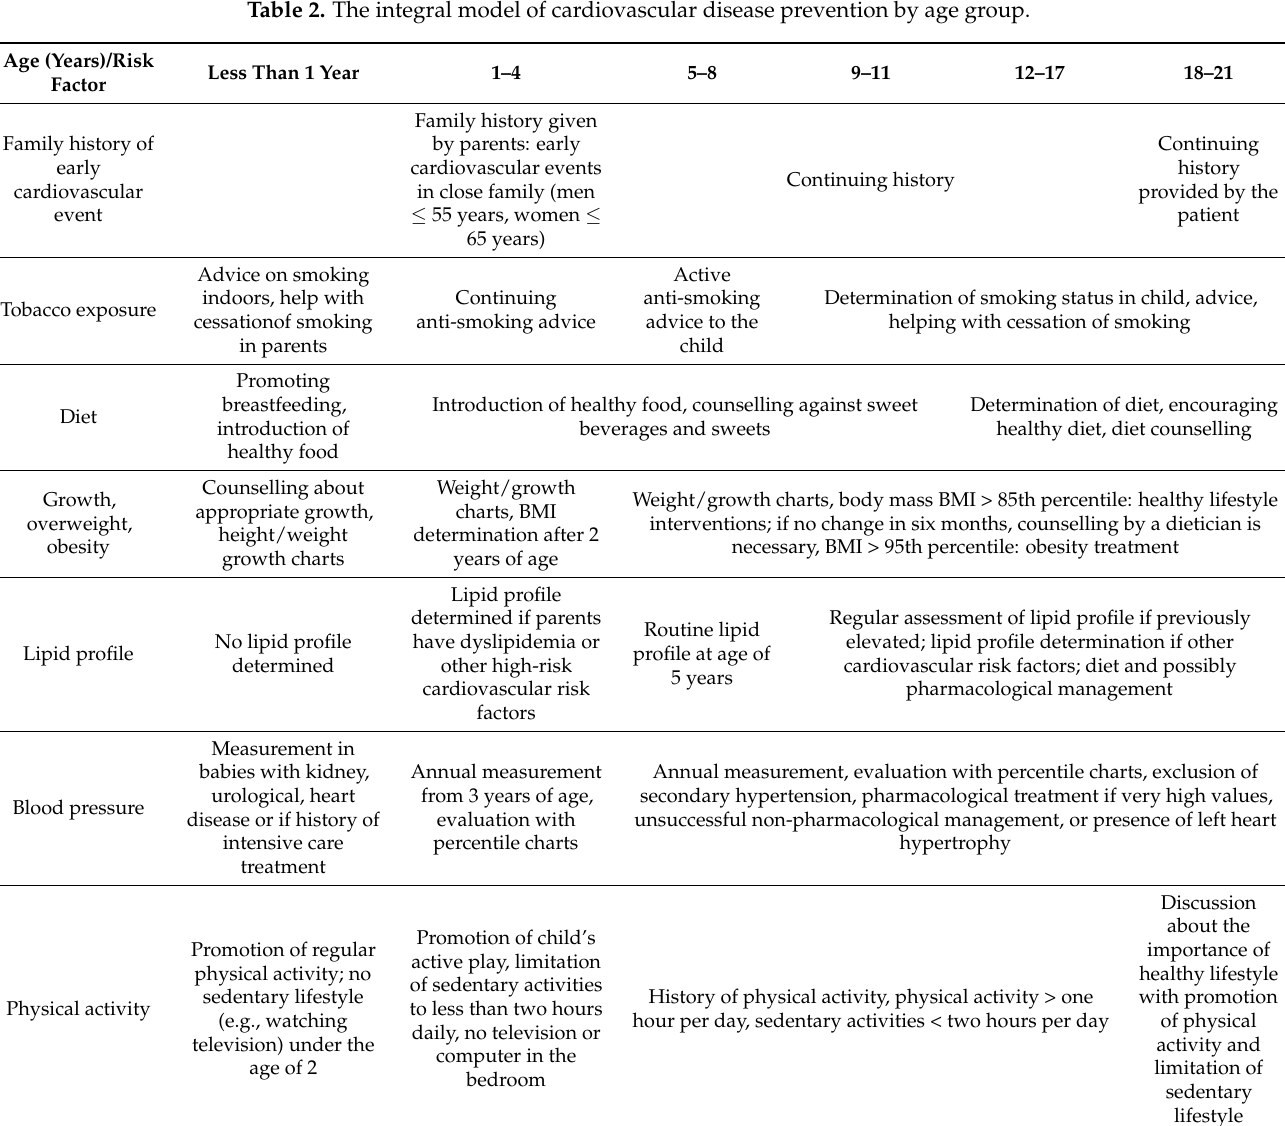
Table 2. The integral model of cardiovascular disease prevention by age